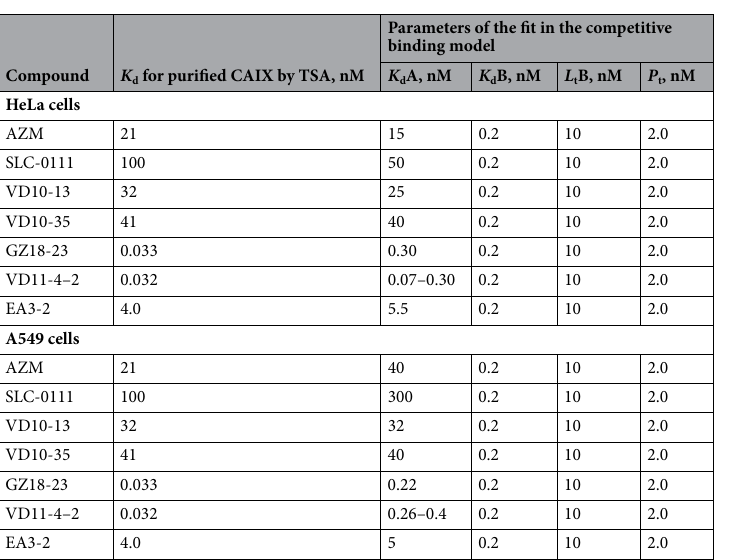
Table 2. Comparison between the K d values for compound binding to recombinantly purified CAIX obtained by TSA and the CAIX expressed on the live cell surface obtained by competitive dosing. Parameters were obtained by applying the competitive binding model to the dosing data in Fig.